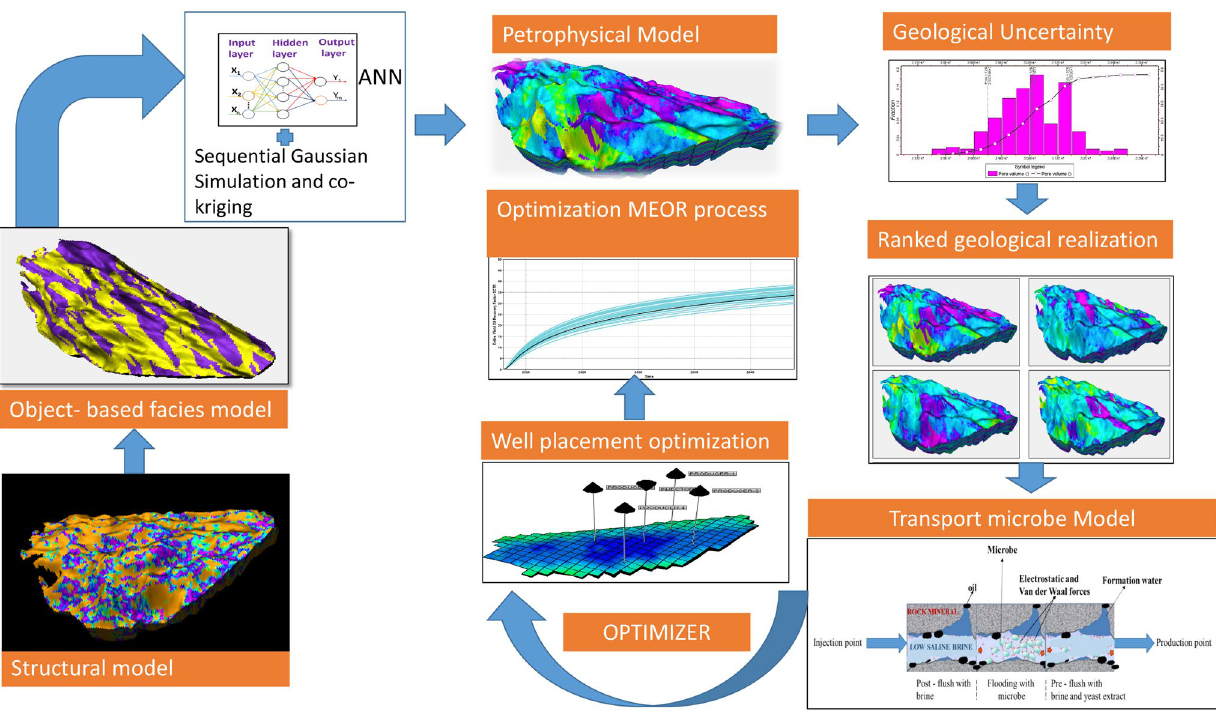
Fig. 13 Schematic of full-field model simulation and optimization